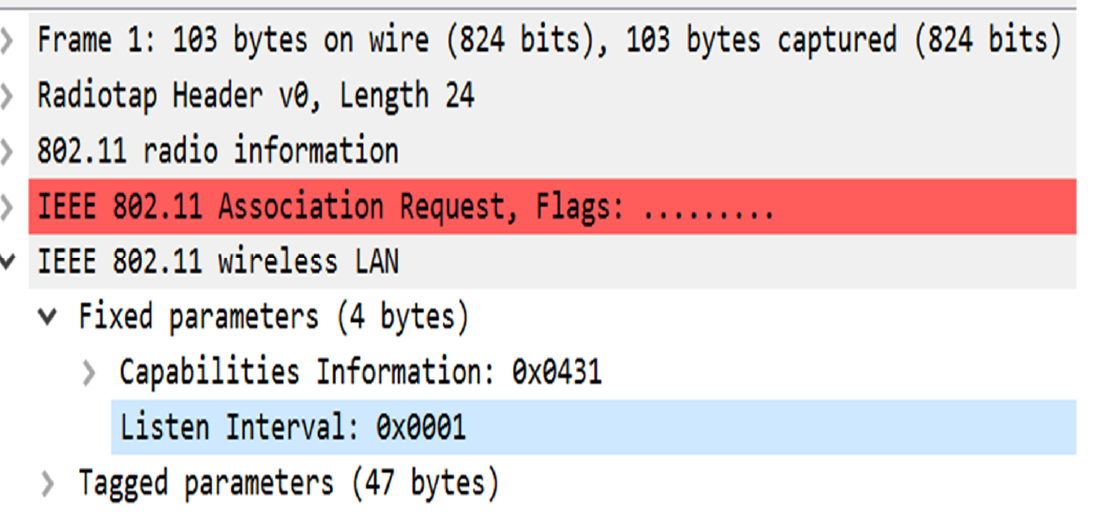
Figure 2. “Listen Interval” under the Association Request frame.